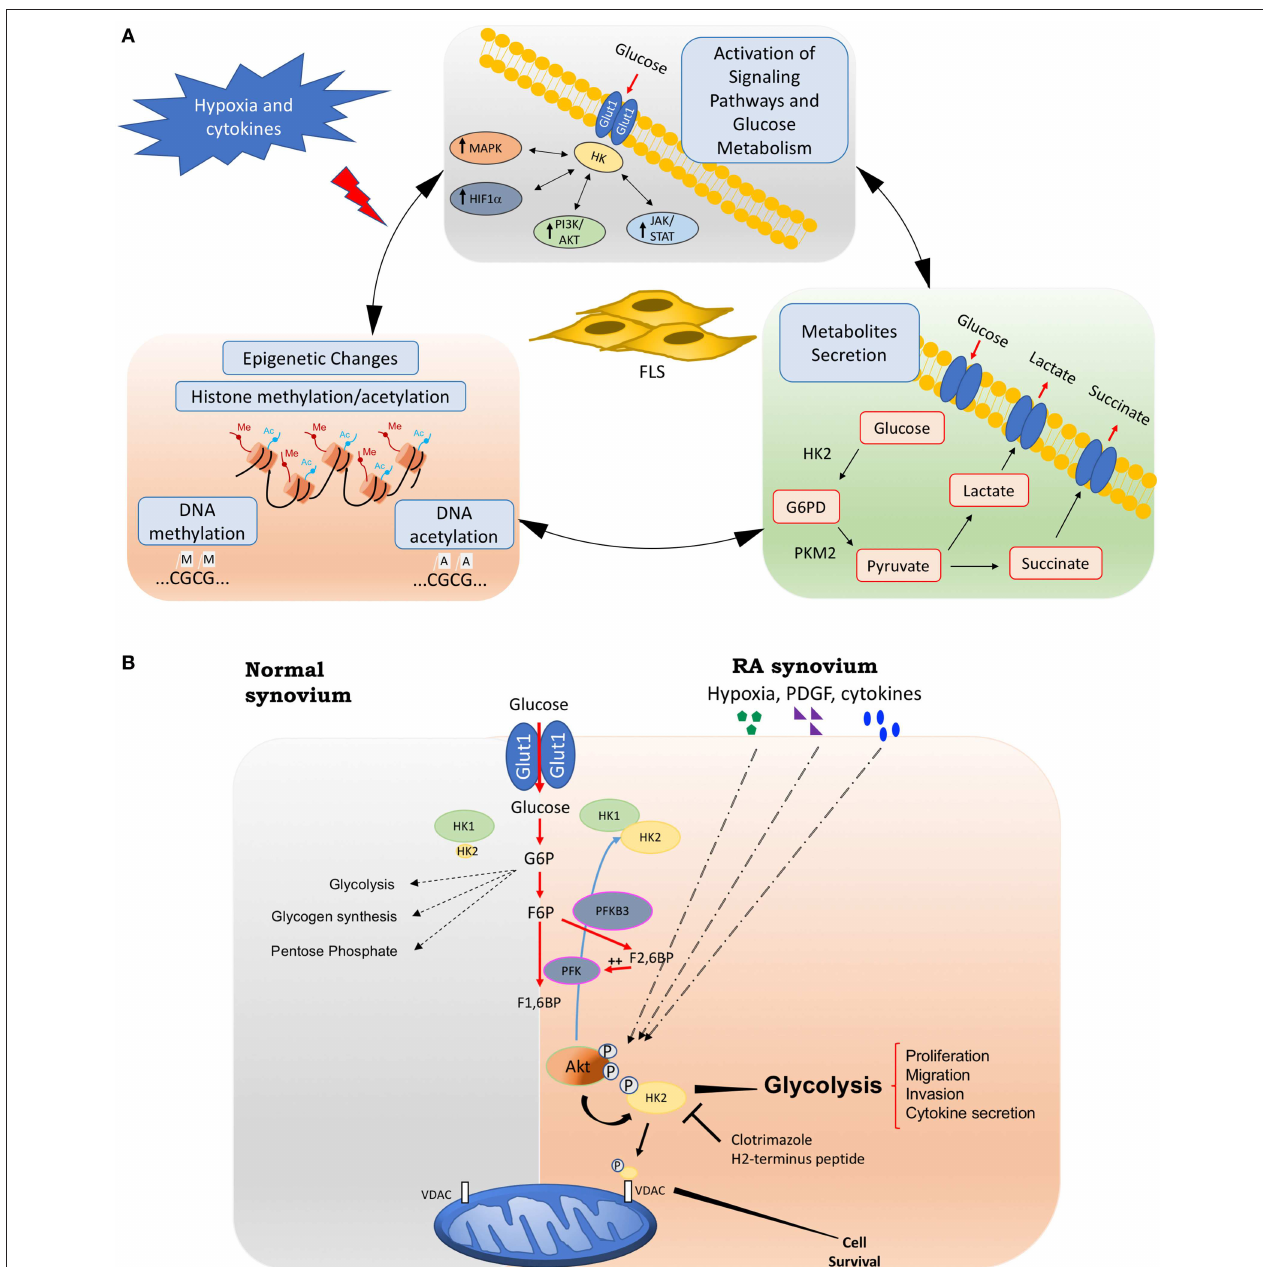
FIGURE 1 | Fibroblasts-like synoviocytes (FLS) glucose metabolism and chronic activation in RA. (A) Chronic glucose metabolic changes induced by hypoxia and inflammatory mediators in FLS will activate many signaling pathways, including HIF, MAPK, PI3K/Akt, and JAK/STAT pathways, which also increases the expression of key glucose metabolism related genes such as GLUT1, HK2, or LDH. Intermediate glucose metabolites including pyruvate, lactate, succinate, a-ketoglutarate, fumarate, and acetyl-coenzyme will create a chronic and sustained FLS activation, either by being secreted extracellularly and triggering profound effects on the biology of other cells, or by inducing a new epigenetic landscape that results in a stable FLS activation that is maintained even without continuous stimulation. (B) Hypoxia, growth factors, and cytokines in arthritis synovium stimulate Akt phosphorylation, which will up-regulate HK2 expression and HK2 phosphorylation. The phosphorylation of HK2 by Akt is accompanied by an increased binding of the enzyme to mitochondrial outer membrane voltage-dependent anion channel (VDAC). Binding to VDAC enhances the affinity of hexokinases. Therefore, HK2 mitochondrial binding might promote glucose metabolism and FLS invasive phenotype. Mitochondrial HK2 might also inhibit apoptosis. Thus, mitochondrial association of HK2 might promote resistance to growth, invasion, and apoptosis of RA FLS, which contribute to joint destruction in RA. Selective HK2 mitochondrial dissociation might be an attractive potential selective target for arthritis therapy and safer than global glycolysis inhibition. HK2, hexokinase 2; G6PD, glucose 6 phosphate dehydrogenase; PKM2, pyruvate kinase muscle isozyme M2; PFK, phosphofructokinase; PFKB3, 6-phosphofructo-2-kinase/fructose-2,6-biphosphatase 3; G6P, glucose-6-phosphate; F6P, fructose-6-phosphate; F1,6BP, Fructose 1,6-bisphosphate; F2,6FB, Fructose 2,6-bisphosphate; VDAC: voltage-dependent anion channel.